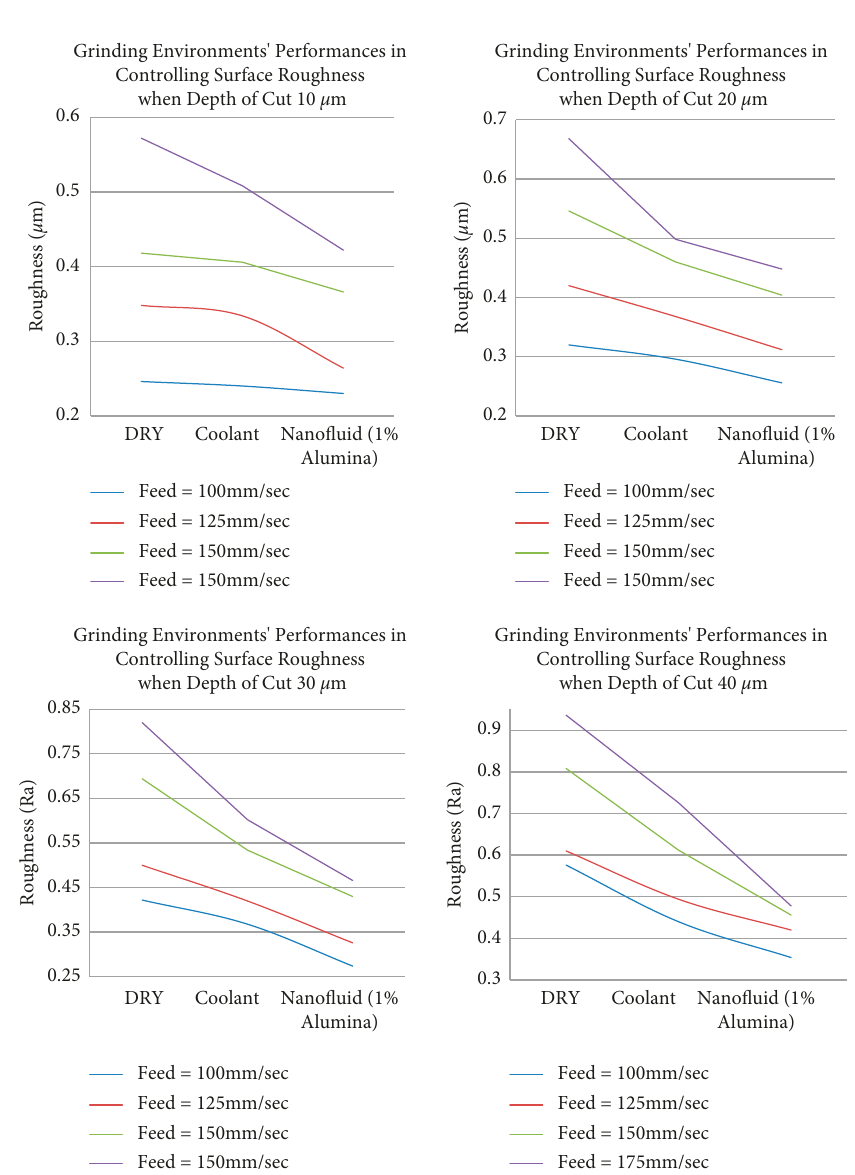
Figure 5: Grinding environments’ performances in controlling surface roughness at a constant depth of